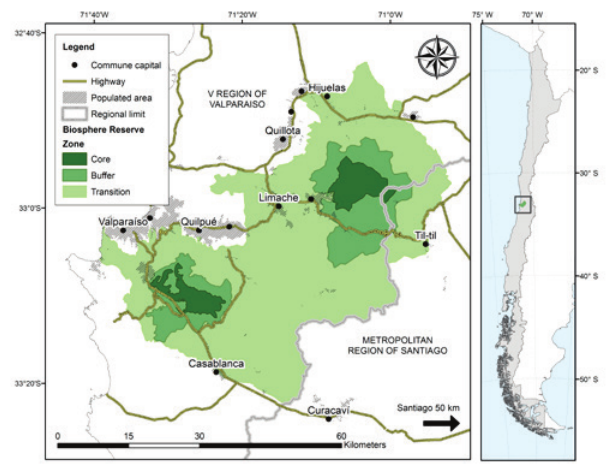
Figure 1. Biosphere Reserve